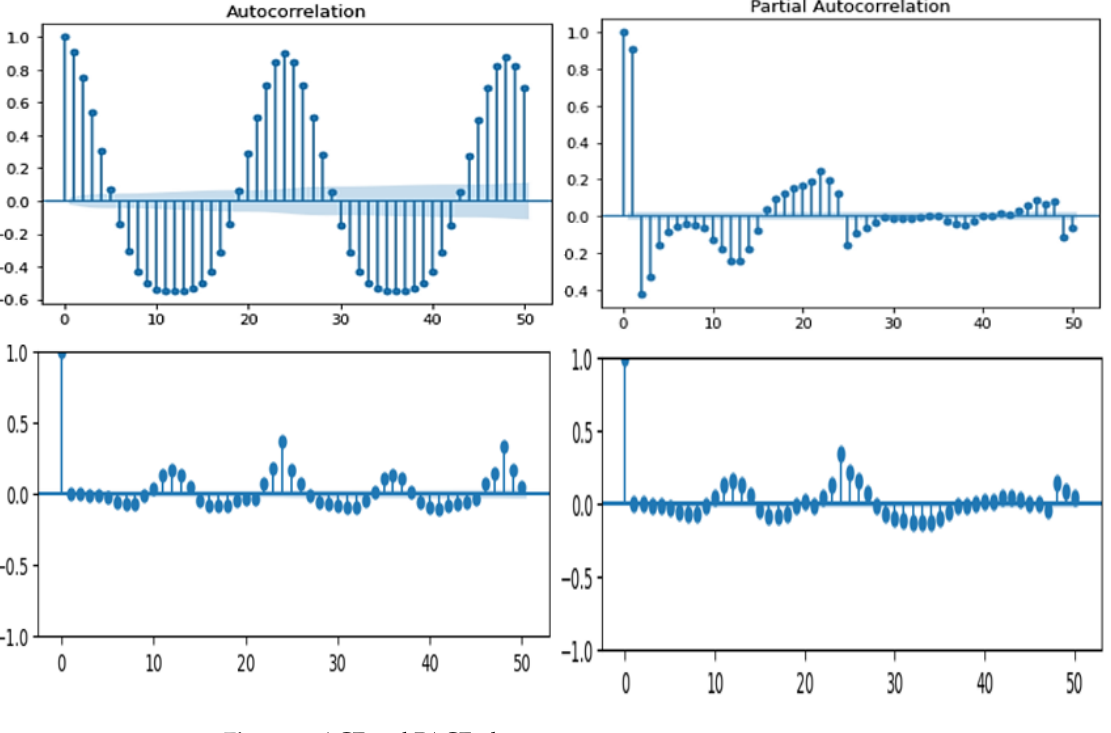
Figure 5. ACF and PACF plot.